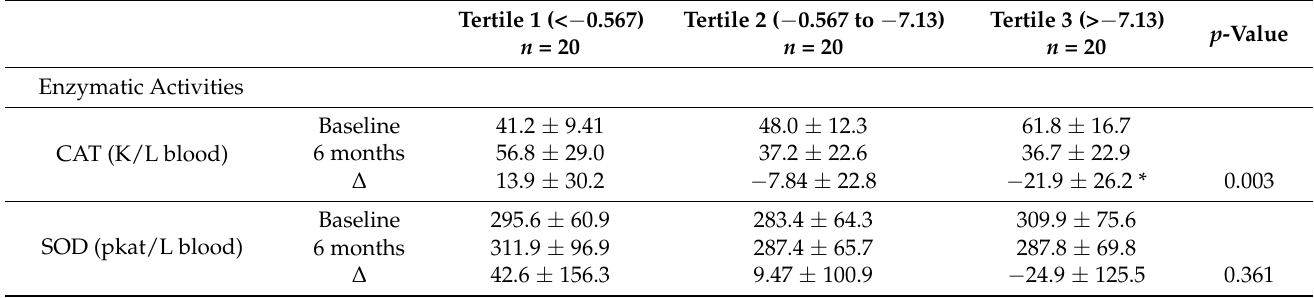
Table 3. Oxidative stress and inflammatory biomarkers in the plasma of patients with NAFLD categorized by tertiles of 6 months change in IFC.